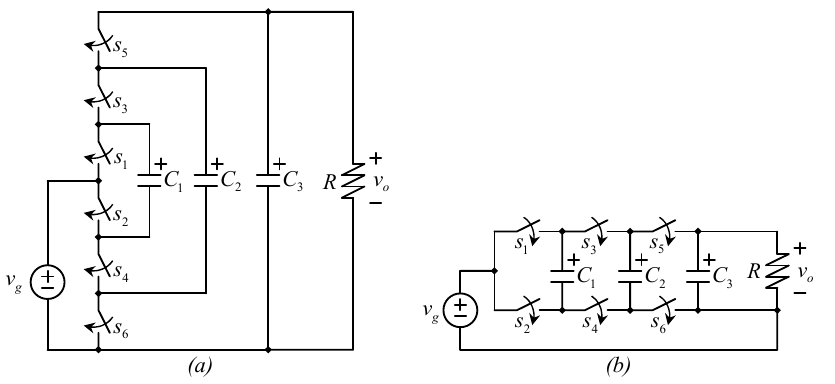
Figure 13. Two common ways of drawing the Flying Capacitor Multilevel Converter (it is the same topology drawn in two different ways), ( a ) drawn in vertical way, ( b ) drawn horizontally.